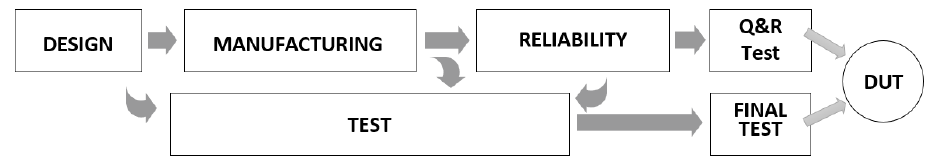
Figure 1. Traditional Reliability Flow.